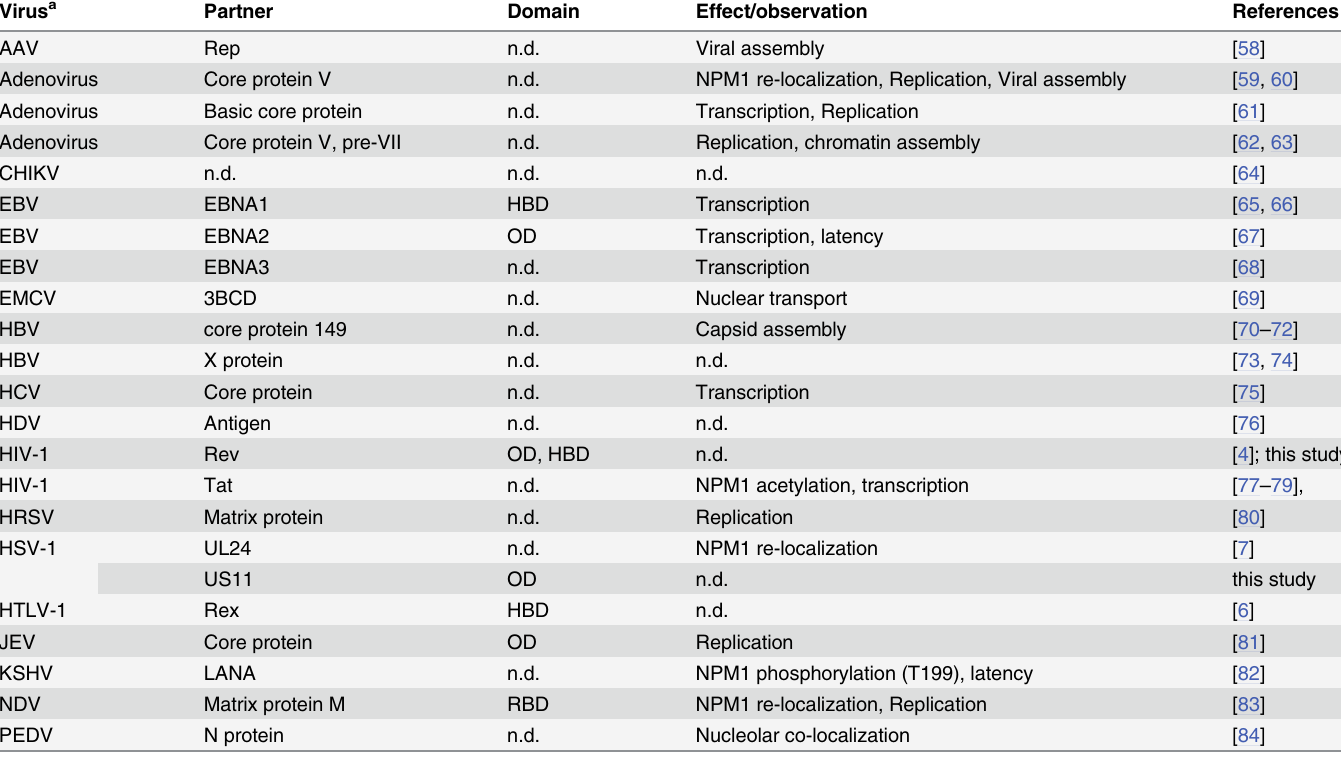
Table 1. Nucleophosmin involvement in multiple viral